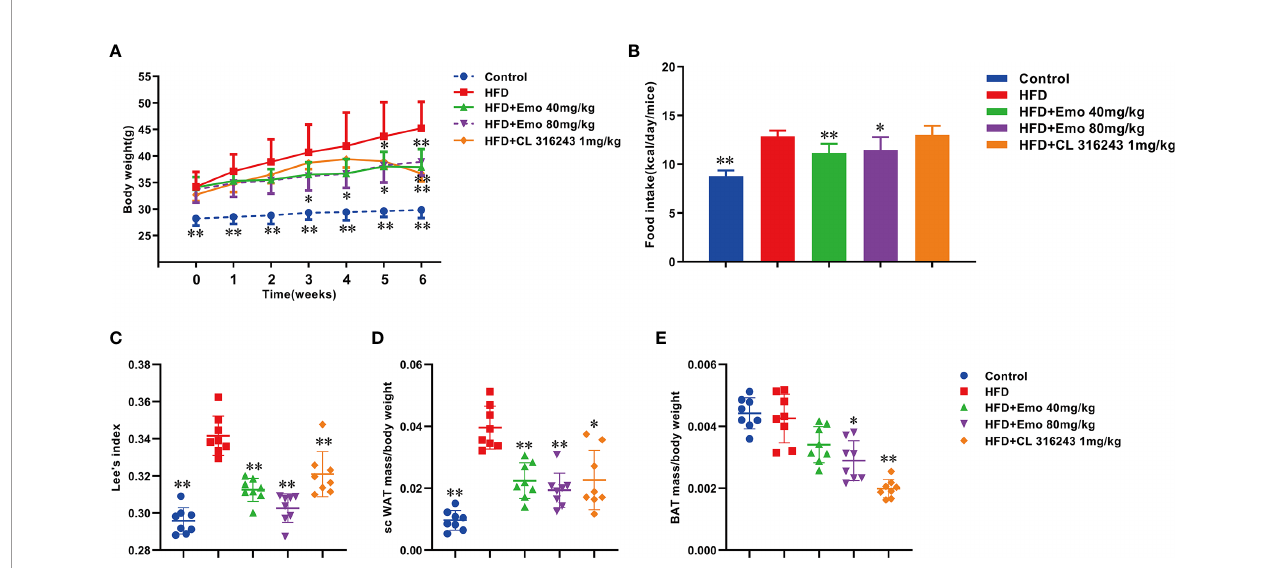
FIGURE 1 | Effects of emodin on body weight, food intake and Lee ’ s index in HFD mice. Mice were fed with high fat diet (HFD) containing 5.24 kcal/g for 8 weeks to induce hyperlipidemia. The mice in HFD+Emo group were intragastrically administered with emodin at the doses of 40 and 80 mg/kg/day respectively for consecutive 6 weeks. The mice in HFD+CL 316243 group were intraperitoneally injected with 1mg/kg/day of CL 316243 disodium salt for 3 days just before detecting time point. (A) Body weight. (B) Food intake. (C) Lee ’ s index. (D) The ratio of scWAT mass/BW. (E) The ratio of BAT mass/BW. HFD, high fat diet; Emo, emodin. Data are expressed as mean ± SE, with n = 8. * P < 0.05, ** P < 0.01 vs. HFD